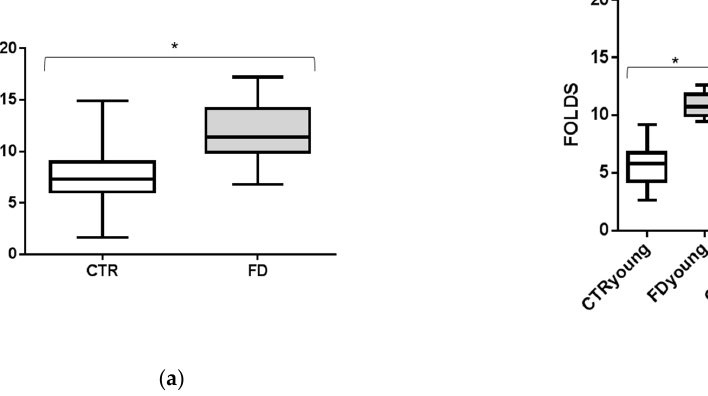
Figure 4. Comparisons of miR-126-3p levels among CTRs and FD patients. Box and Whiskers indicate median, minimum, and maximum levels of miR-126-3p in sEVs from plasma of all FD patients (30) and all CTRs (60) ( a ). Comparisons of miR-126-3p levels among CTRLs and FD patients subdivided into three age classes: young, adult, and old ( b ). CTs (cycle thresholds) resulting from qRT-PCR analysis were normalized with miR-30a; levels were calculated with 2- ∆ CT method and expressed as folds with respect to lowest value registered. * p from t -test <